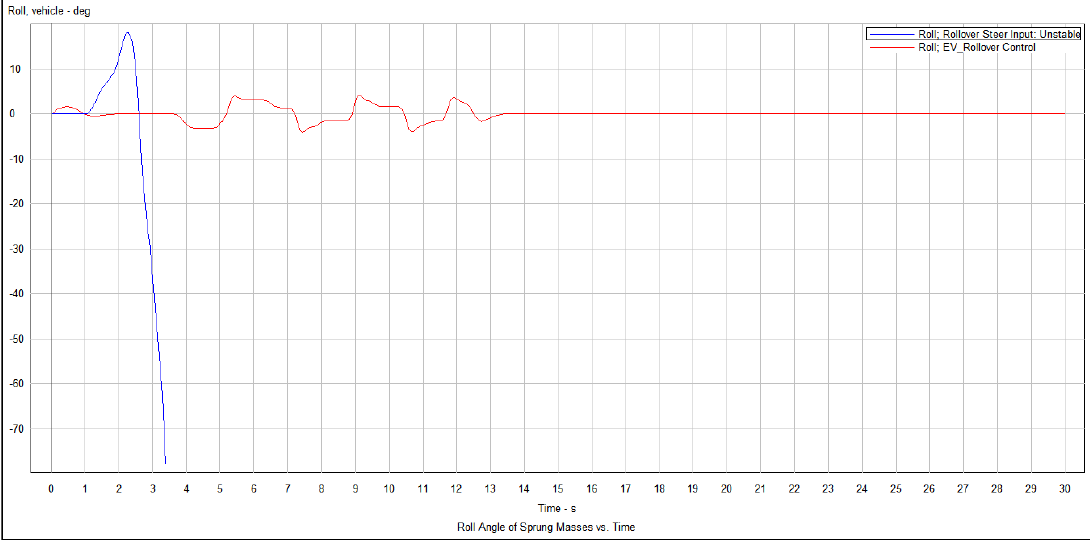
Figure 12. Roll angle comparison curve for double lane-change test.